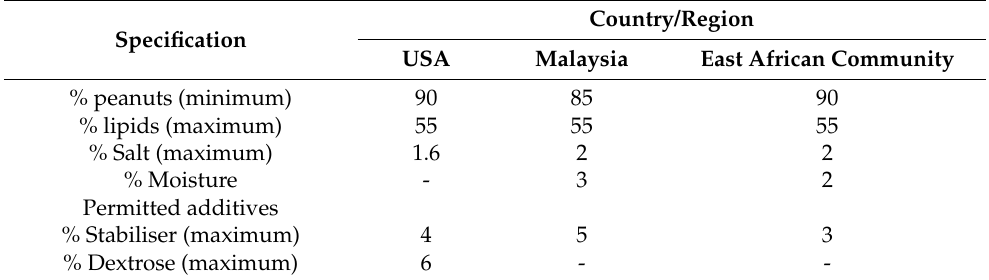
Table 1. Peanut butter standards for USA, Malaysia, and East African Community [66–69]. Specification